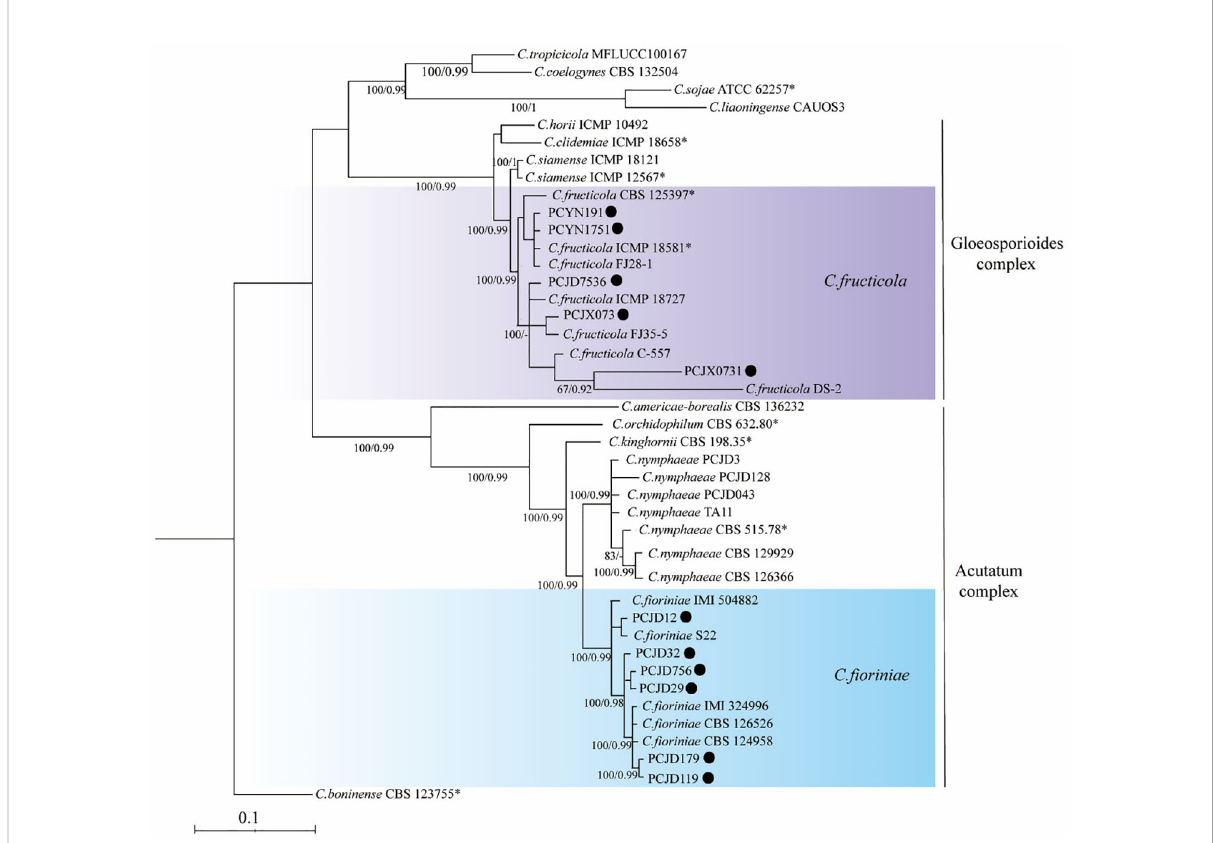
FIGURE 2 A maximum likelihood phylogenetic tree based on concatenated sequences of internal transcribed spacer ( ITS ), actin ( ACT ), calmodulin ( CAL ), glyceraldehyde-3phosphate dehydrogenase ( GAPDH ), b -tubulin ( TUB2 ), and chitin synthase 1 ( CHS-1 ). The tree illustrates the relationships between Colletotrichum fi oriniae and C. fructicola. C. boninense (CBS 123755*) was used as an outgroup. Bayesian posterior probability values ≥ 0.90 and UFbootstrap support values ≥ 50% are shown at the